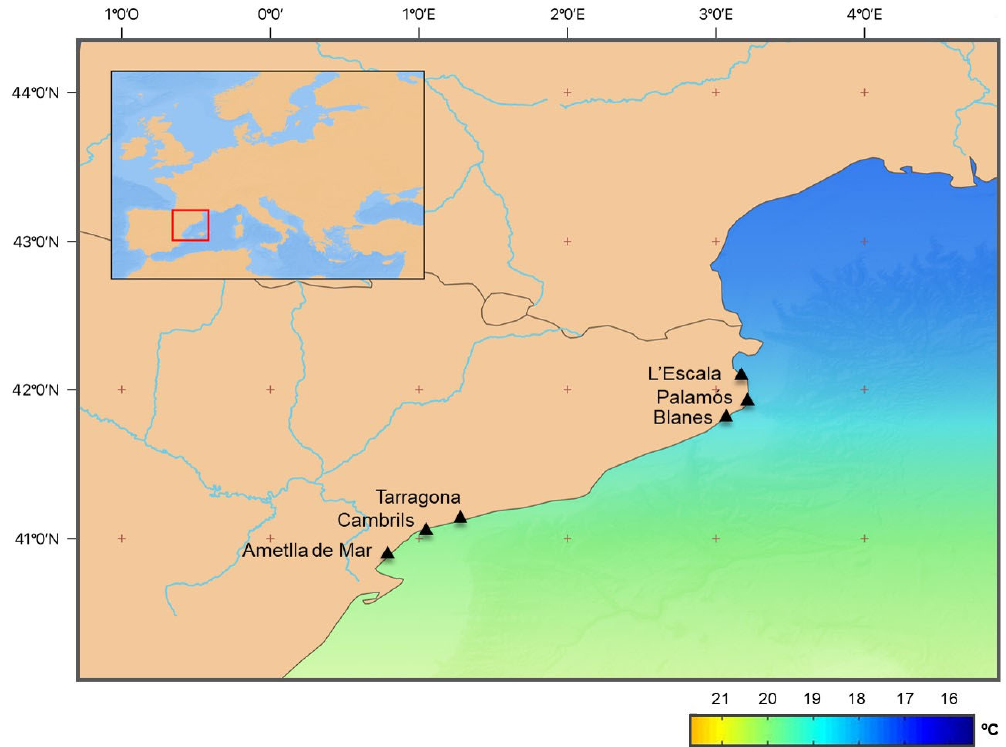
Figure 1. Map of the Catalan Coast in the western Mediterranean Sea showing sea surface temperature (SST, °C) to delimit thermal regimes and the fishing harbours where Sardina pilchardus was caught (FAO ‐ GFCM geographical subarea GSA ‐ 06, Northern Spain). Along the northern coast, the locations of l’Escala, Palamós and Blanes are indicated; on the southern coast are the locations of Tarragona, Cambrils and Ametlla de Mar. Temperature (°C) was retrieved monthly from